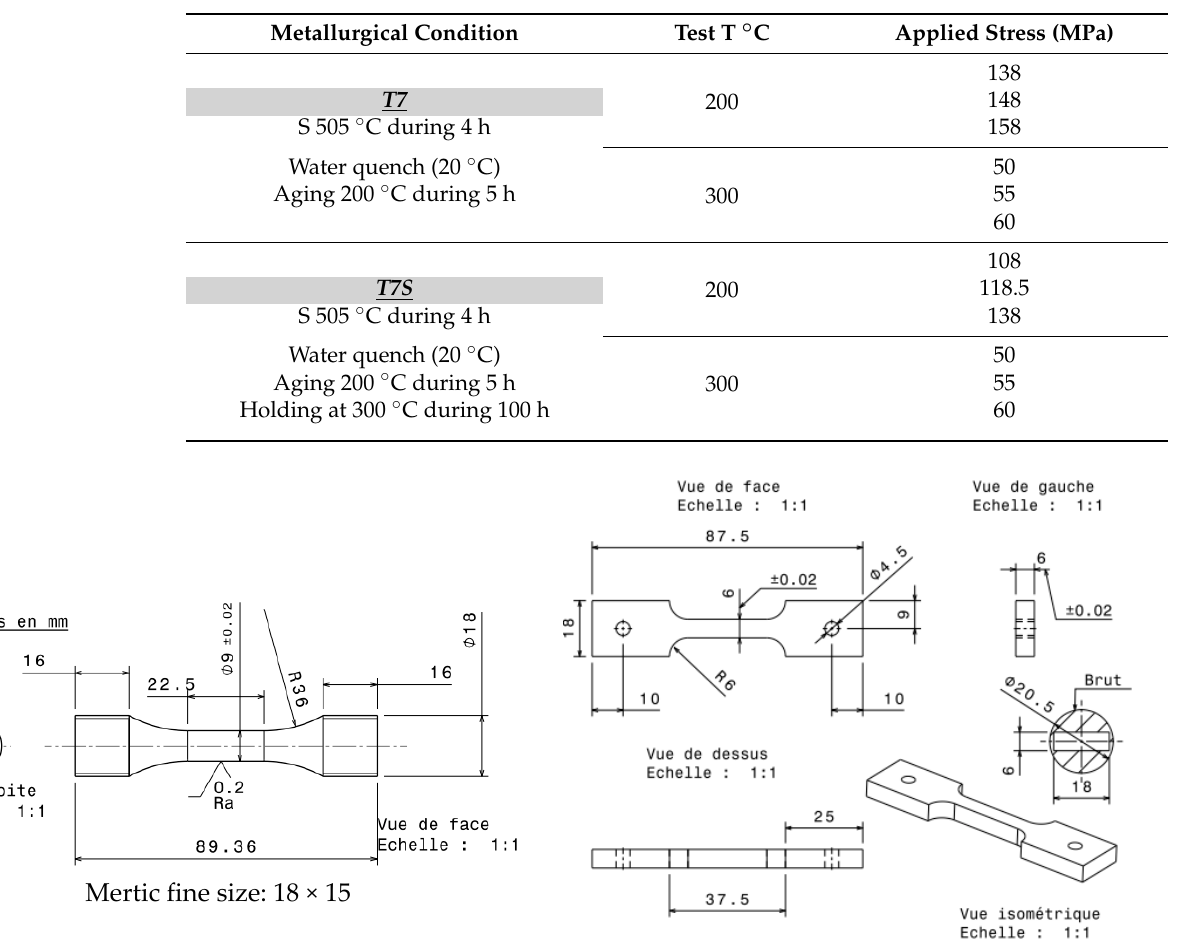
Table 2. Creep test parameters for LM&C identification.